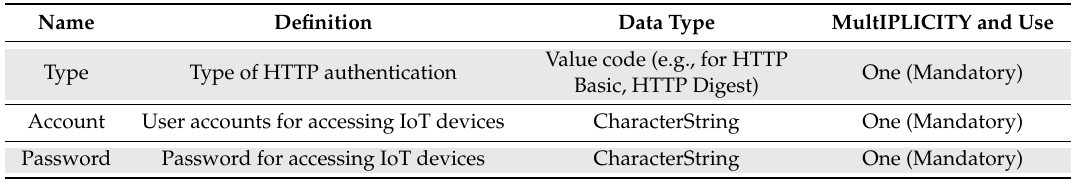
Table 9. Properties of the Authentication